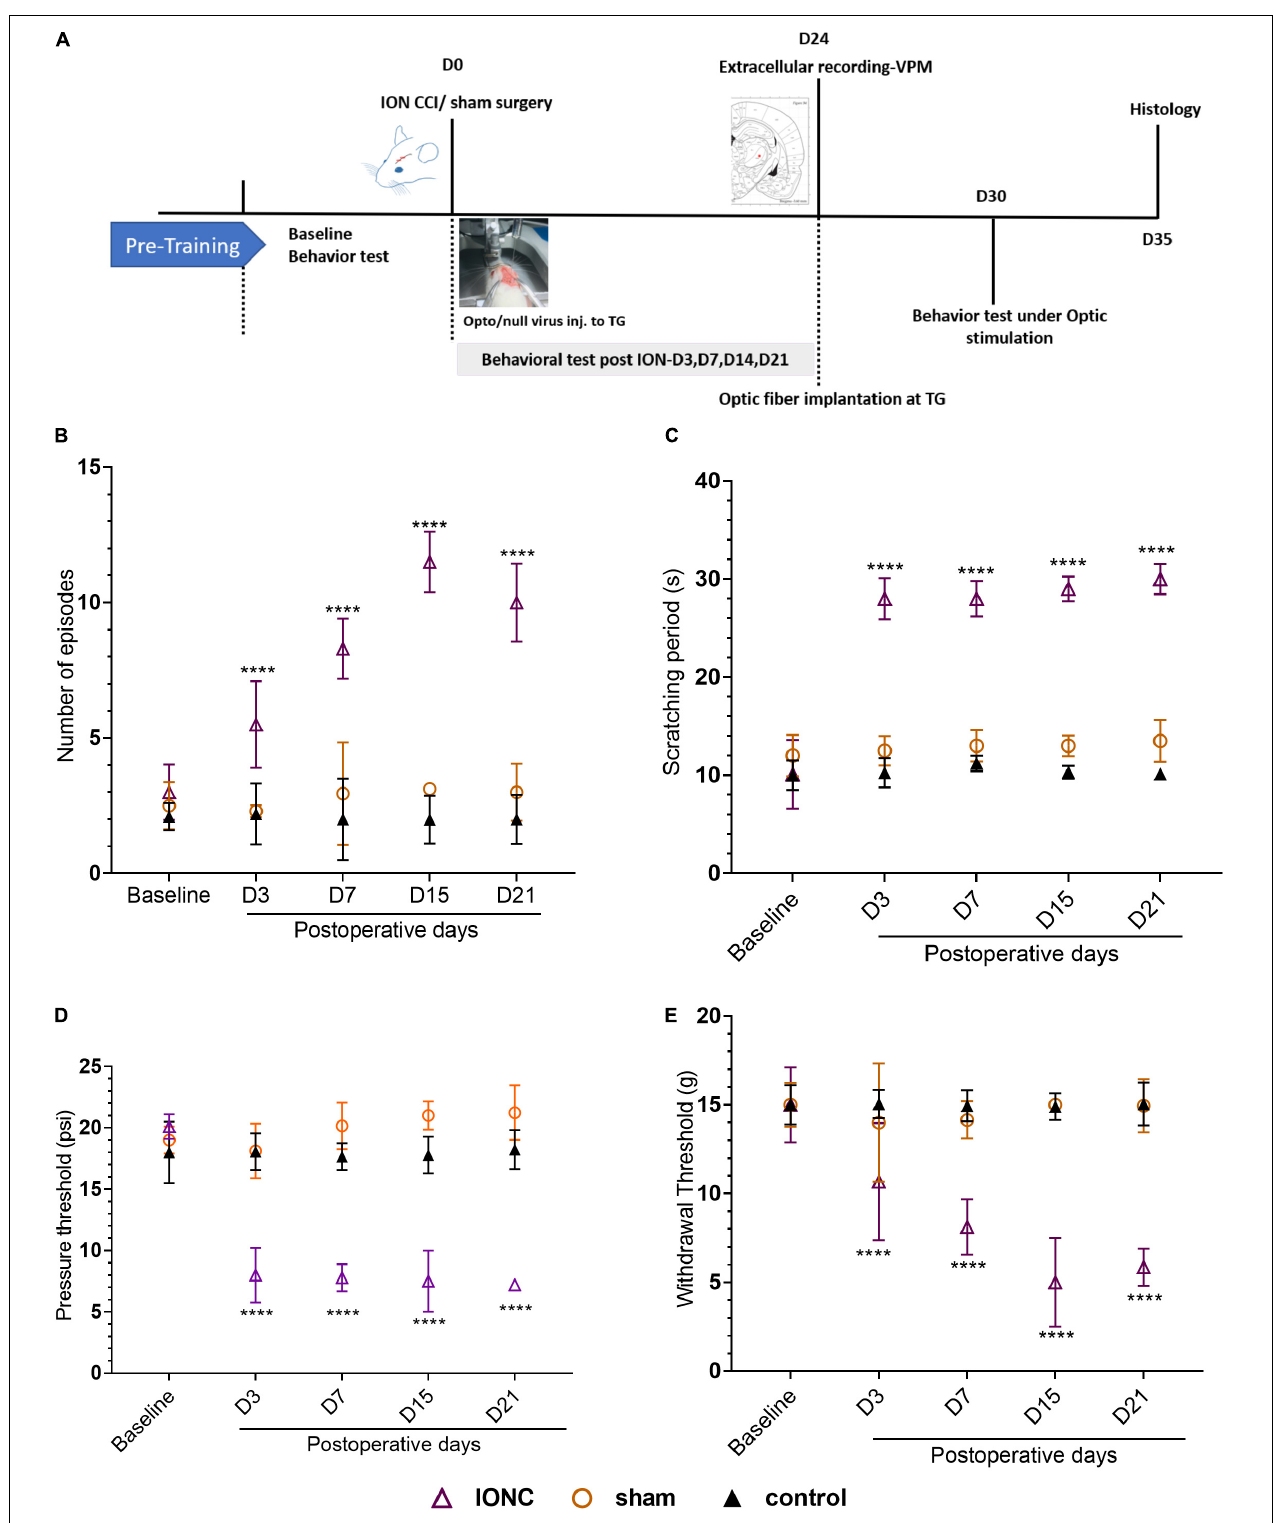
FIGURE 1 | Study design and orofacial pain behavior test. (A) Experimental design shown in days. (B) Incline in number of episodes in face grooming test following IONC. (C) Increased scratching period (in seconds) in acetone test was notedin IONC. (D) Decreased air pressure threshold (in psi) in ipsilateral orofacial area following IONCin air puff test. (E) Decreased mechanical face withdrawal threshold (in grams) following IONC. In (B–E) , data are presented as the mean ± SD. **** P < 0.0001 (two-way ANOVA) compared to sham and control group.